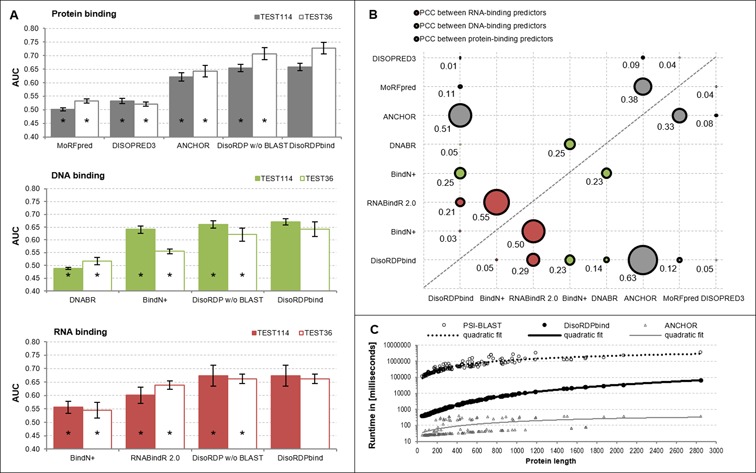
Empirical assessment of the prediction of the disordered RNA-, DNA- and protein-binding residues. (A) predictive performance measured with AUC calculated per residue and significance of differences in AUC values when comparing DisoRDPbind with other methods on two benchmark data sets: TEST114 (solid bars) and TEST36 (hollow bars); * means that AUC of a given method is statistically significantly lower than AUC of DisoRDPbind at P-value < 0.05; statistical significance was assessed over 10 random subsets with half of proteins from a given test set; error bars show the corresponding standard errors (details in Online Methods). ‘DisoRDP w/o BLAST’ denotes DisoRDPbind without the use of the BLAST-based alignment. (B) PCC values between the propensity scores generated by the pairs of RNA- (red dots), DNA- (green dots) and protein- (black dots) binding predictors listed on the x and y-axes; results for the TEST114 and TEST36 data sets are shown above and below the dashed diagonal line, respectively; dot sizes are proportional to the corresponding PCC value that are shown next to the dots. (C) Relation between length of protein chains (x-axis) and the runtime (y-axis in the logarithmic scale) computed for proteins from the TEST114 and TEST36 data sets using a modern desktop; we include DisoRDPbind (solid circles), ANCHOR (hollow triangles), and one iteration of PSI-BLAST (hollow circles); the solid black, solid gray and dotted black lines represent the quadratic fit for DisoRDPbind, ANCHOR and PSI-BLAST, respectively.